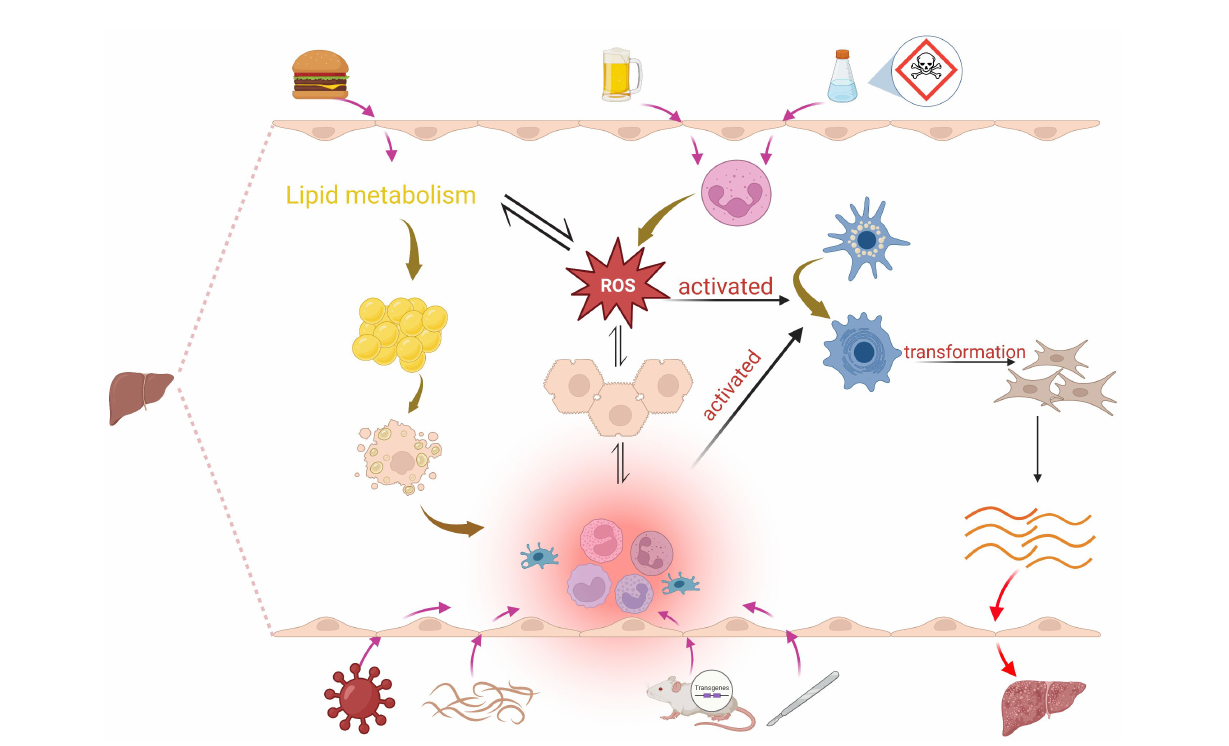
FIGURE 1 Mechanisms of induction in the liver fibrosis model: Chemical induction mainly leads to massive infiltration of neutrophils to produce ROS, which induces hepatocyte injury and activation of HSCs, and also interferes with lipid metabolism; hepatocyte injury significantly increases the production of immune cells such as cytokines, chemokine, Kupffer cells, B cells, T cells and ROS, and this pro-inflammatory environment and ROS activates HSC, promotes the conversion of HSC into myofibroblasts, and increased production of ECM proteins, which subsequently leads to liver fibrosis. Dietary induction mainly affects lipid metabolism, which leads to ROS as well as fat accumulation, and excessive accumulation of lipids in hepatocytes also activates inflammation. Surgery, transgenic, and immune induction induce liver fibrosis mainly by causing